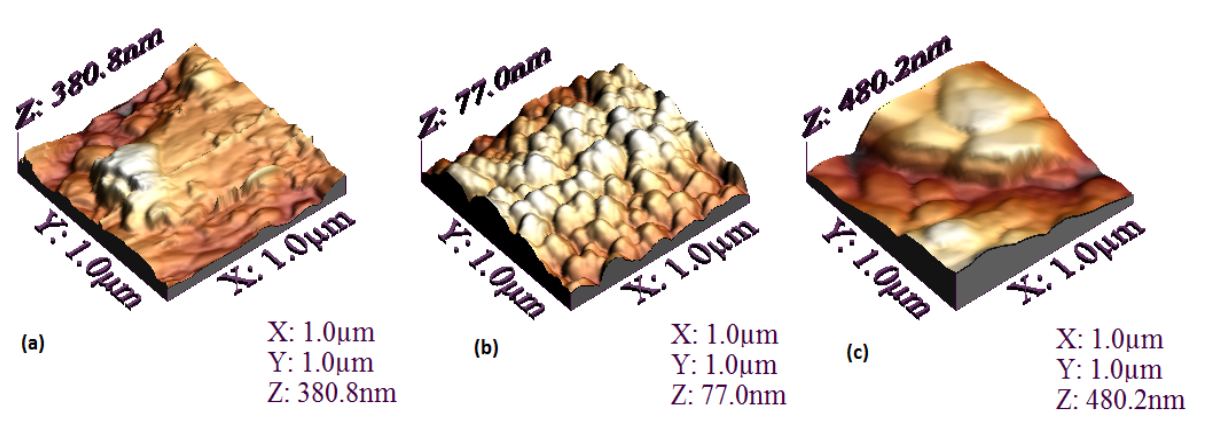
Figure 3. Atomic force microscopy (AFM) images for: ( a ) Compound A ; ( b ) Compound B ; and ( c ) Compound C films deposited on Q-substrate.